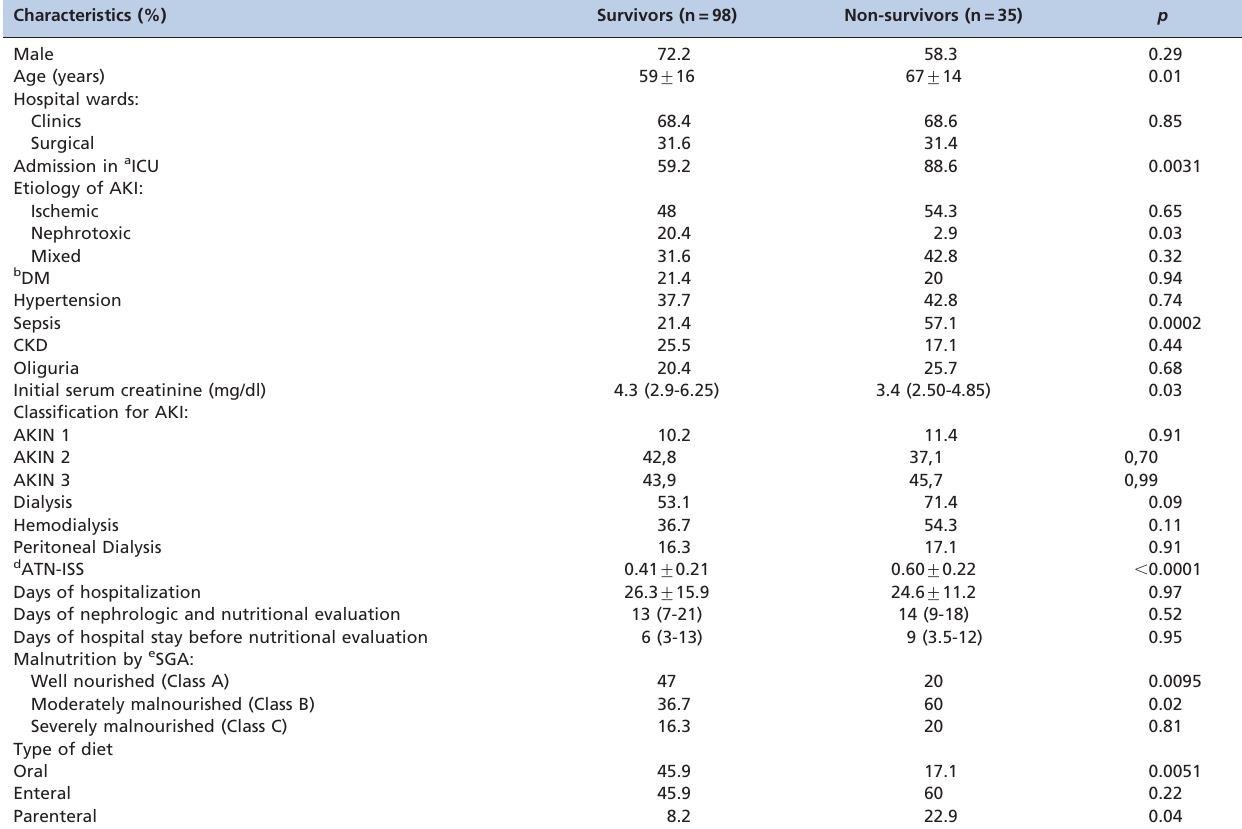
Table 1 - Clinical characteristics of the acute kidney injury patients according to